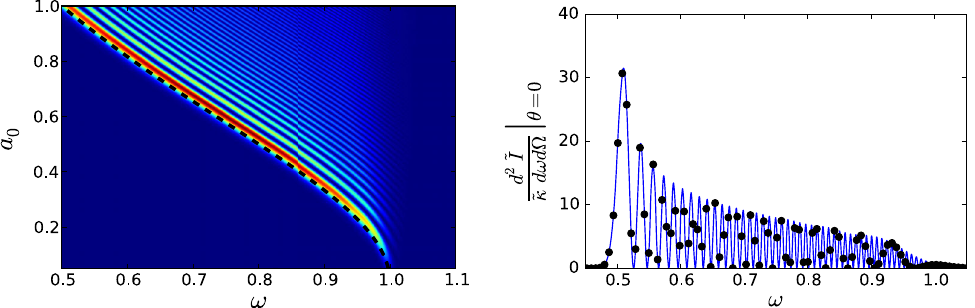
FIG. 2. Left: On-axis radiation spectra plotted as a function of laser pulse amplitude a 0 (vertical axis). The spectra are in arbitrary ¼ 600 . The dashed black line represents the redshift of the peak units, from numerical integration of Eq. (14). Laser pulse duration is τ L of the spectrum according to Eq. (1). Right: On-axis radiation spectrum for a 0 ¼ 1 from the analytical expression of Eq. (16) (black circles) for such frequencies as make the order of the Bessel function given by Eq. (17) an integer, overplotted with the full spectrum from numerical integration (blue